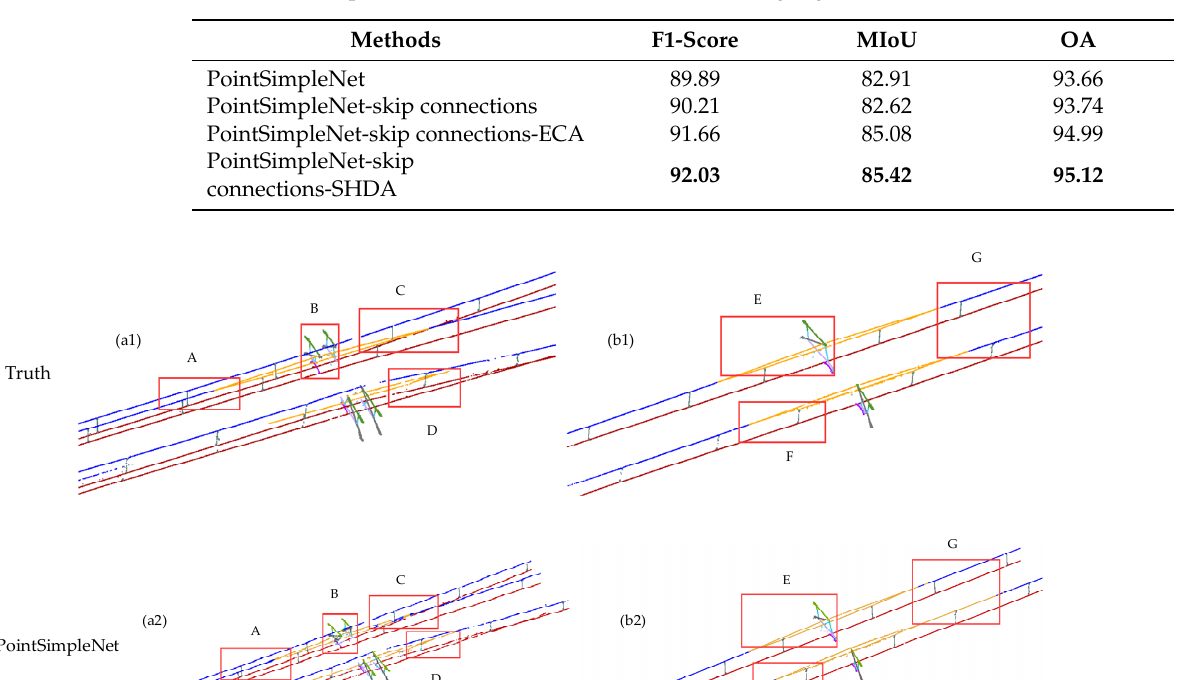
Table 7. Quantitative evaluation of SHDA structure through four groups of comparative experiments (%) on the OCS point cloud dataset. The best metrics are highlighted in bold.